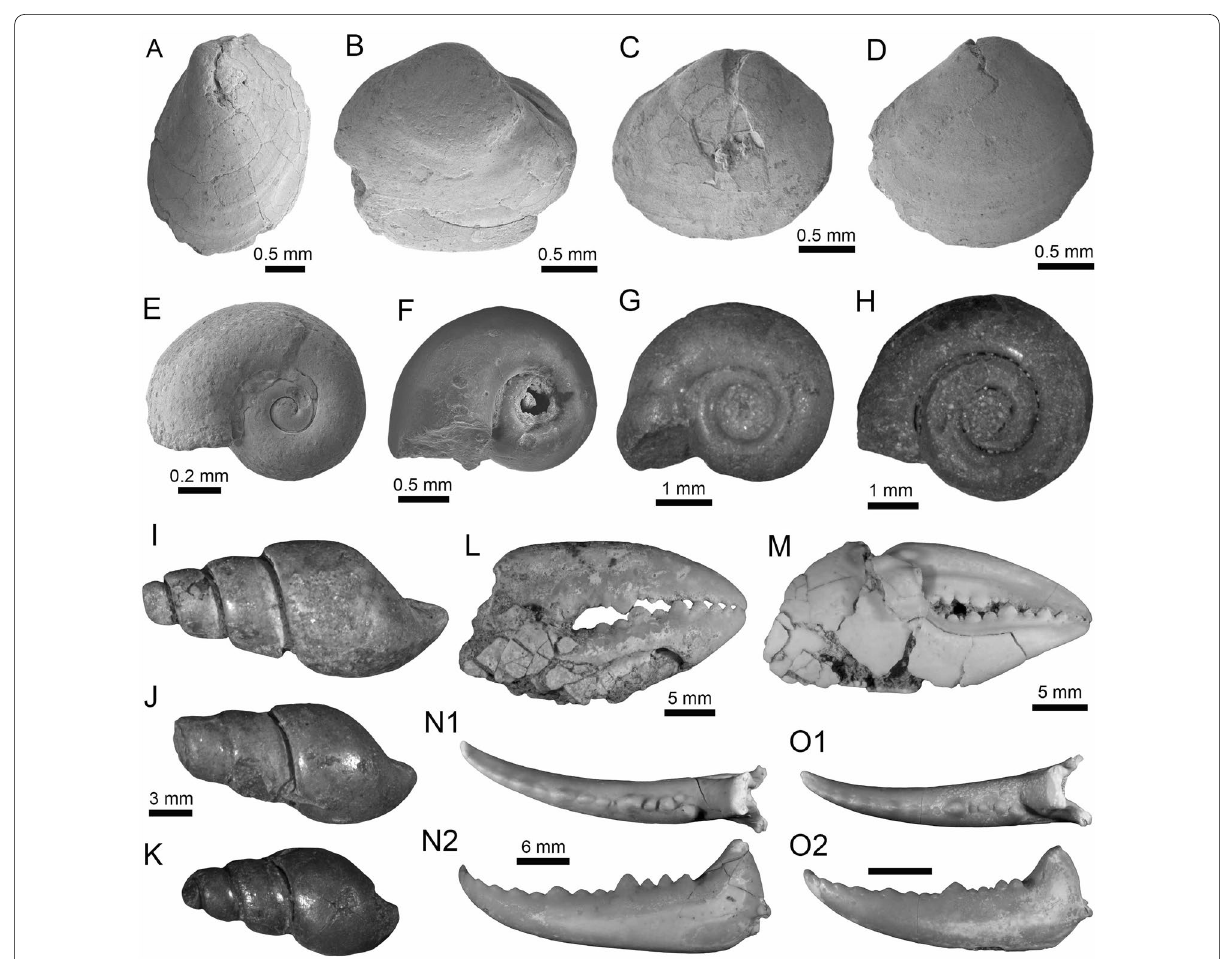
Fig. 34 Freshwater molluscs and crustaceans from the Vergel Member. A – D Internal molds of indeterminate bivalves (AMU‑PI‑81). E – H Internal molds of gastropods (AMU‑PI‑82) presumably related to Planorbidae. J , K Internal molds of indeterminate gastropods (AMU‑PI‑83). L – O2 Right chelae ( L , M ) and moveable fingers (dactyl: N1 – O2 ) of indeterminate freshwater crabs Trichodactylidae